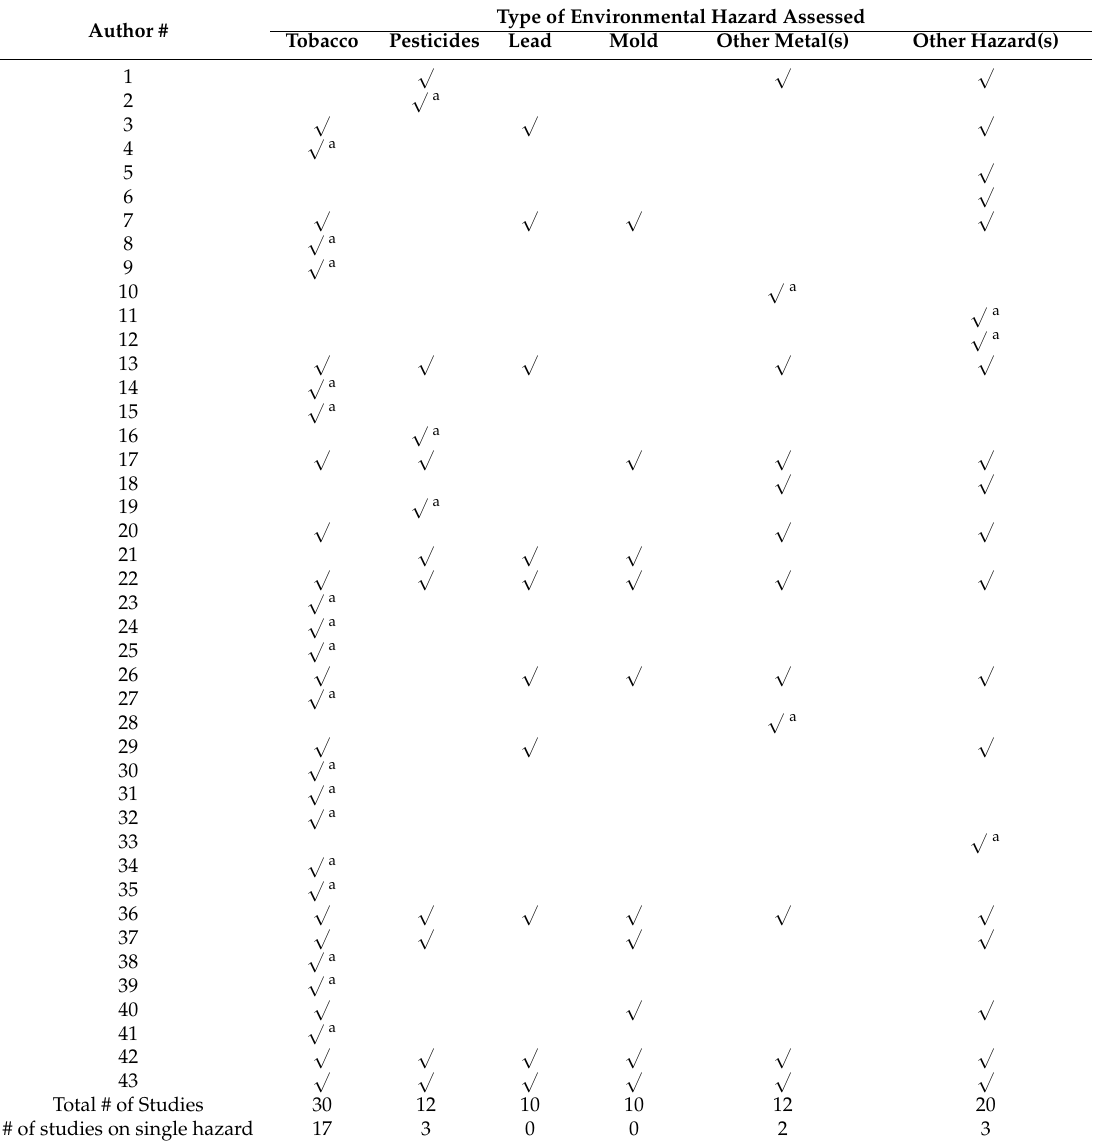
Table 2. Type of environmental hazard assessed in